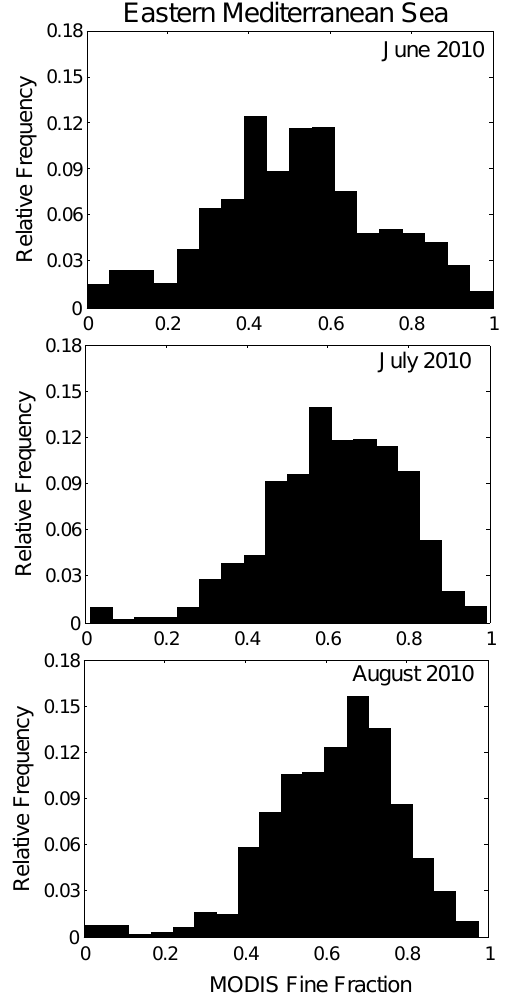
Figure 7. Relative frequency of MODIS fine fraction (ff) occur- rence during June–August 2010 over the ROI.